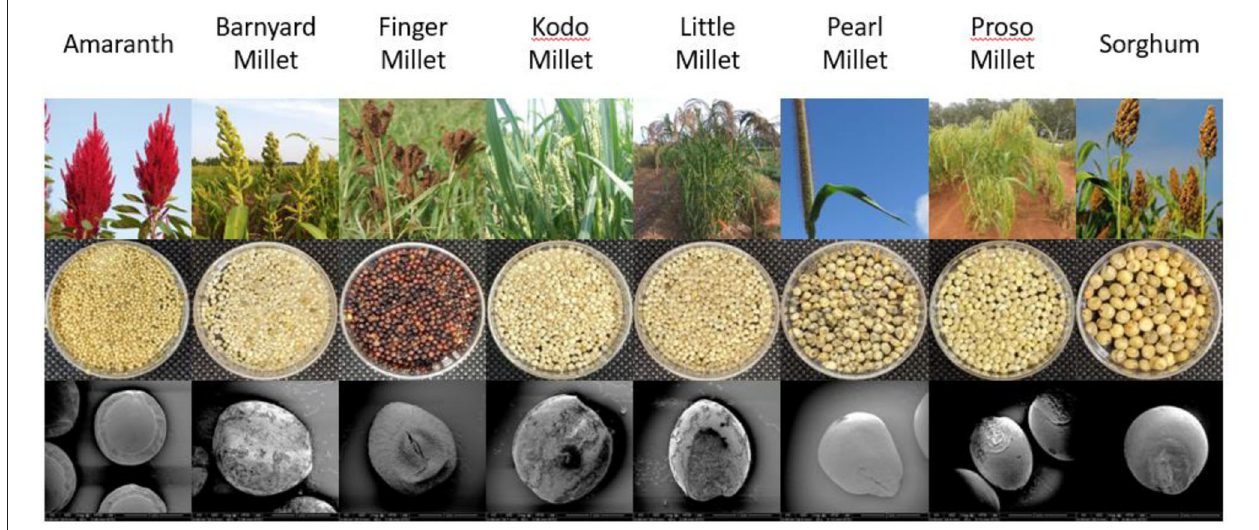
contrast, proso millet is from a colder climate, originating from Central and Eastern Asia, so it performs better in cooler areas. Millets generally reach maturity faster than crops like maize or wheat. Foxtail and proso millet can mature in 60–90